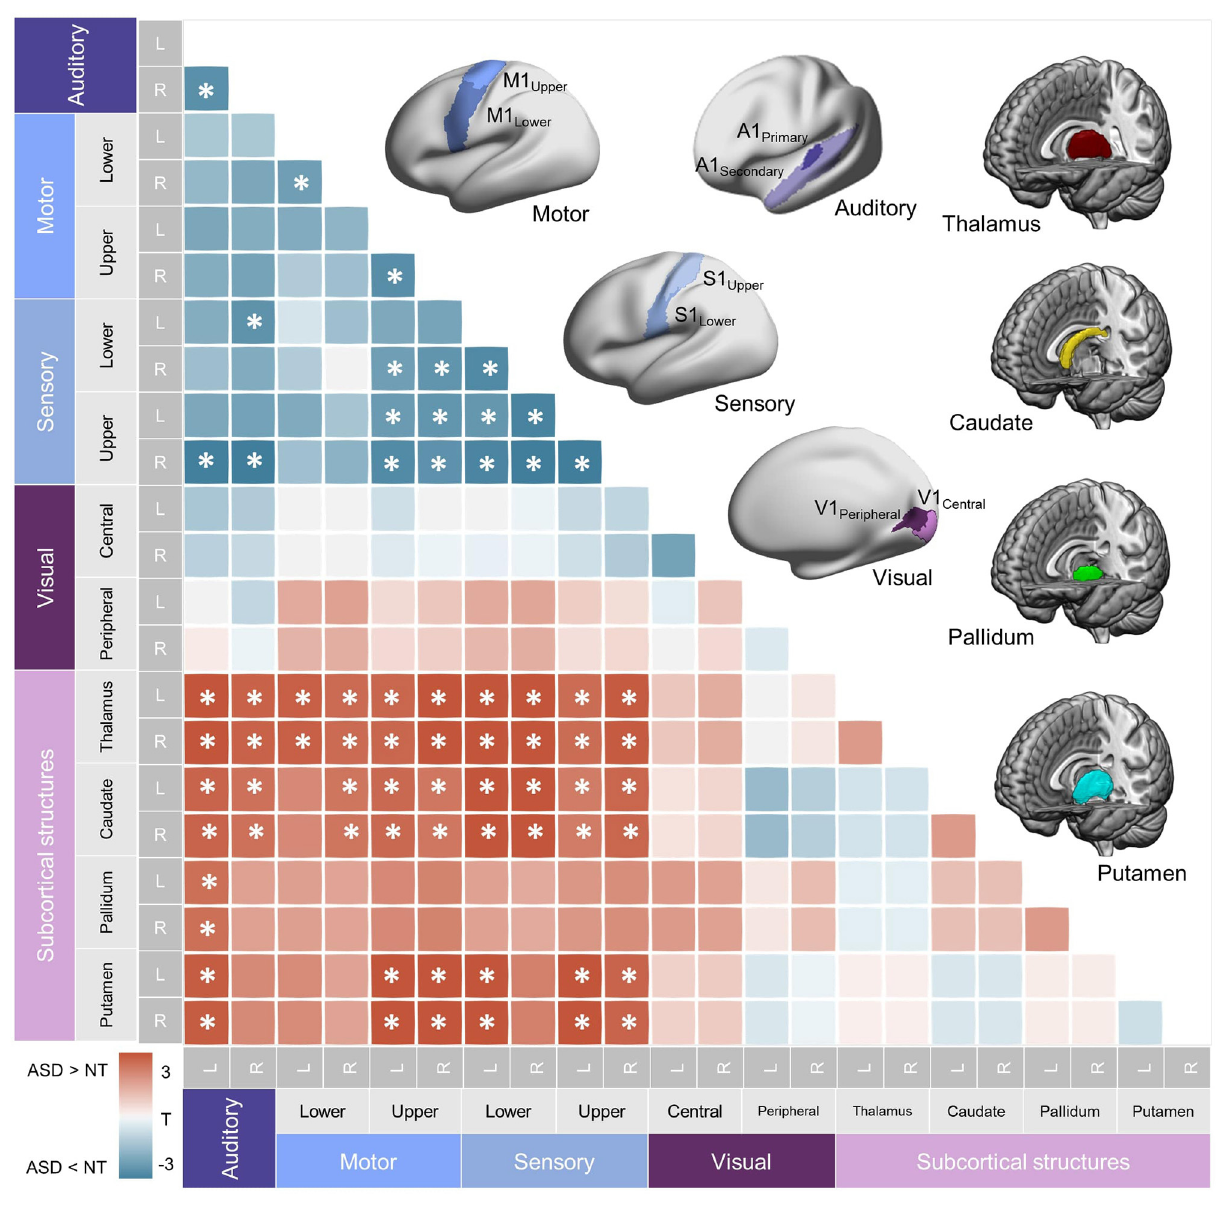
were tested to compare “cross-sectional” aging effects between ASD and NT. All models included age, acquisition site, and framewise displacement (and sex for the replication data) as covariates and were conducted as two-tailed tests. Correction for family-wise errors due to multiple comparisons were performed using the random field theory method with a cluster level correction of p FWE < 0.05 (cluster defined at p =